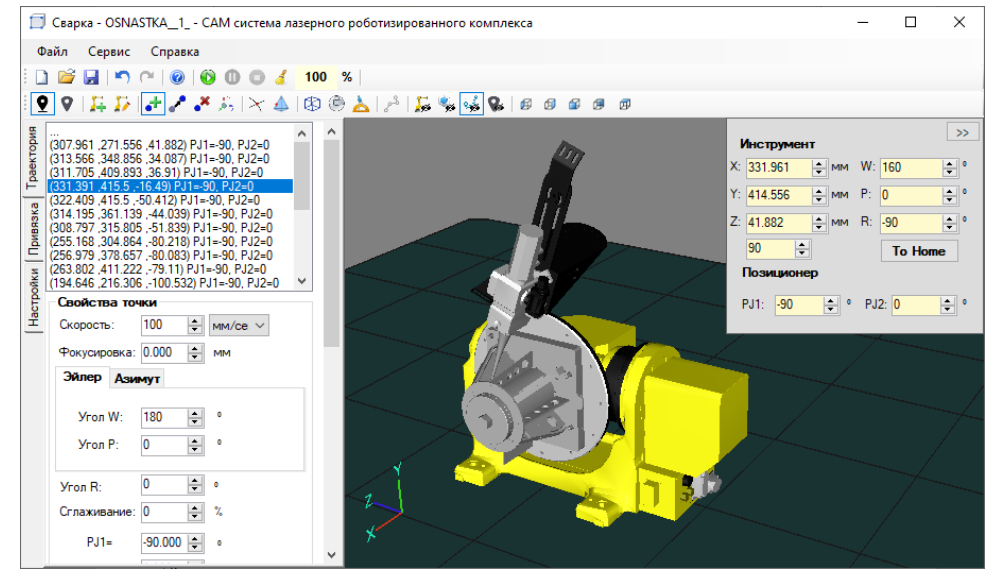
Figure 6. The authors’ system for the technological preparation of a laser robotic complex.